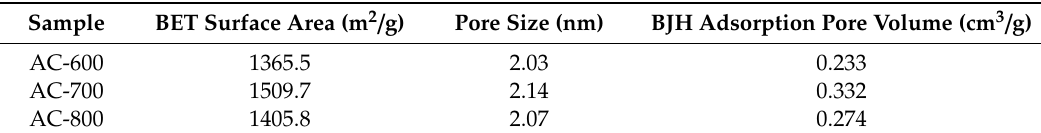
Table 1. Pore structure characteristics of Activated carbon.